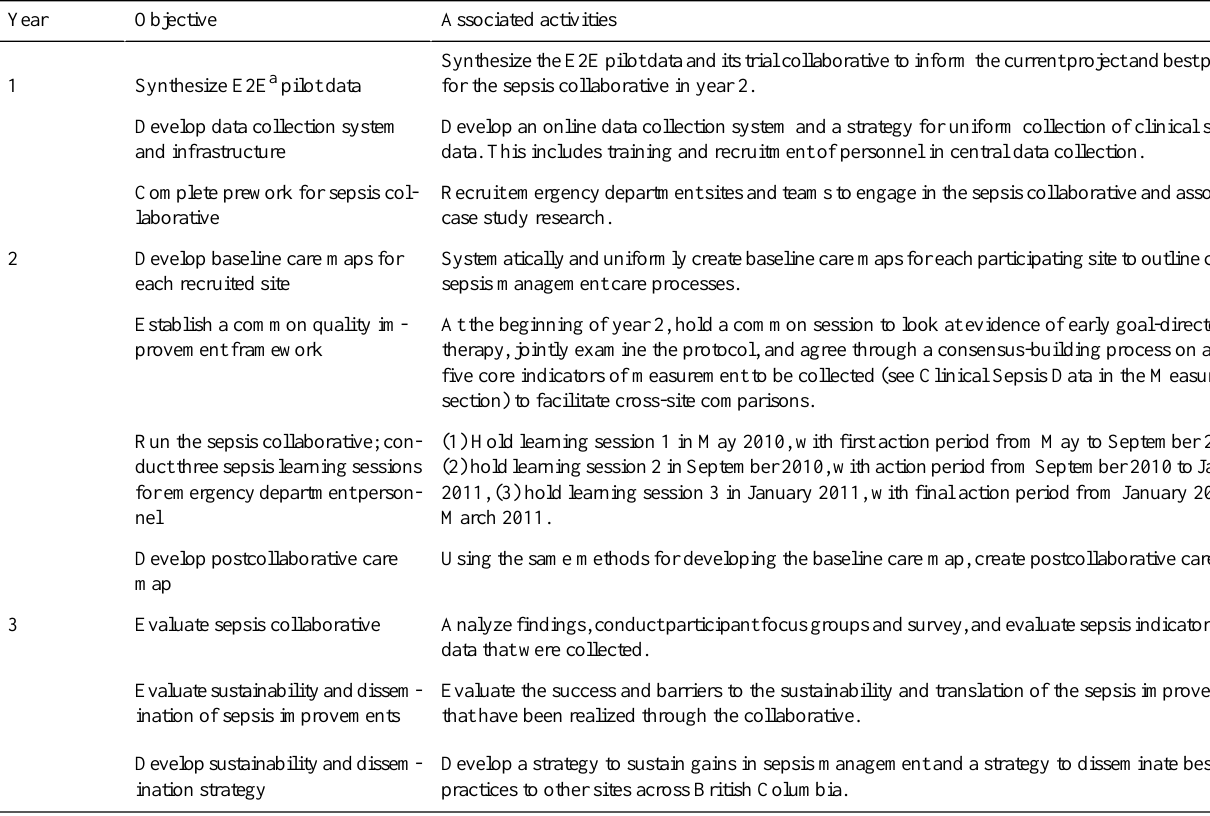
Table 1. Main activities of the 3-year sepsis quality improvement collaborative project. Associated